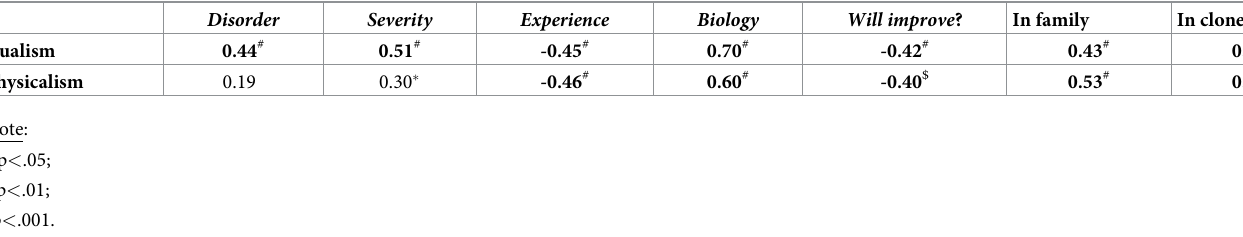
Table 2. Correlation between the perceived tendency of dyslexia to affect the brain and its perceived origins and